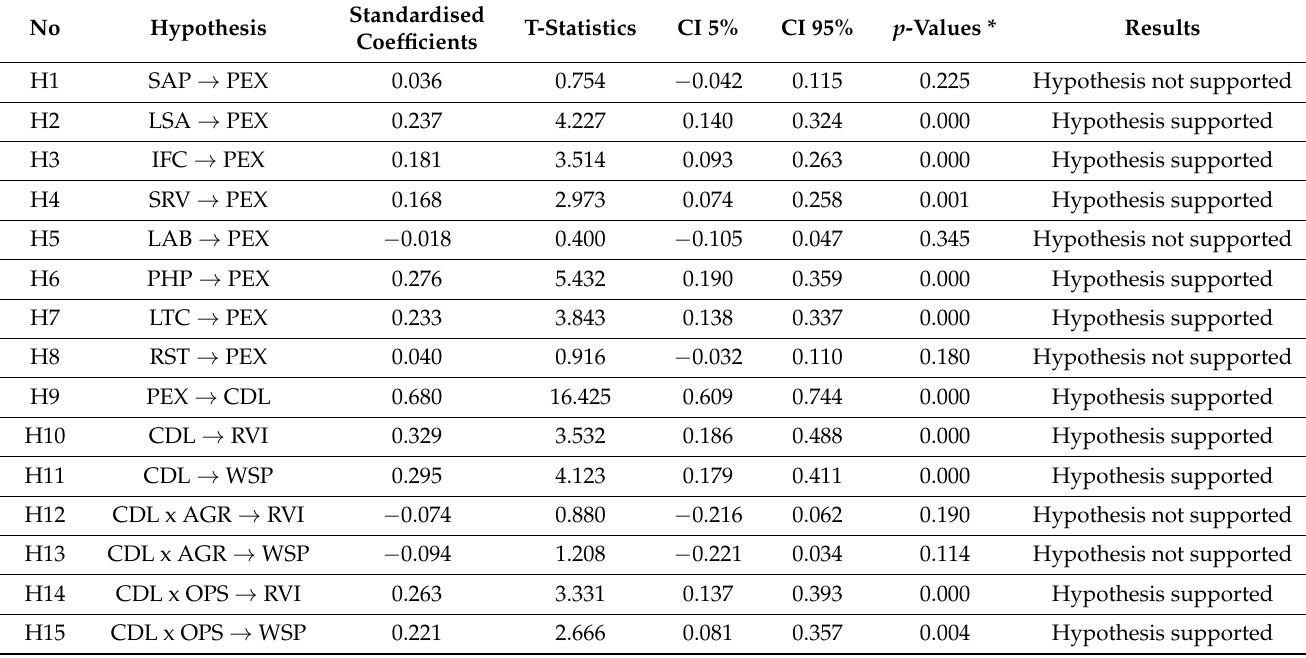
Table 7. Hypothesis test